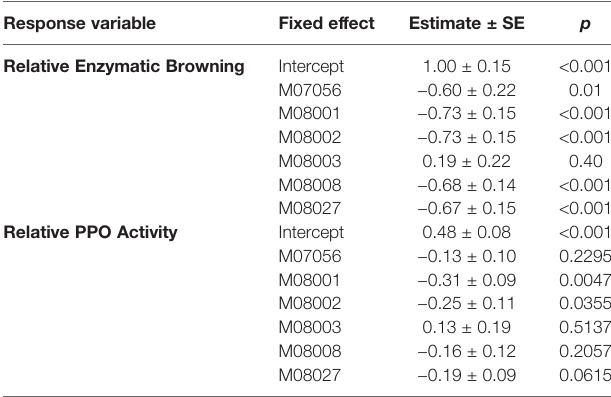
TABLE 2 | Effect of each line on Relative Enzymatic Browning and Relative PPO Activity